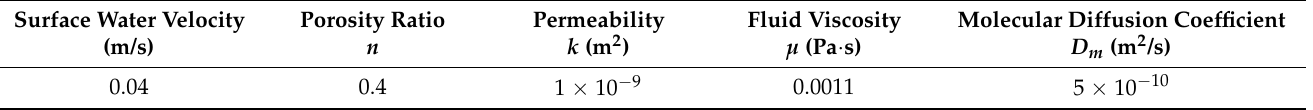
Table 1. Parameter settings of the numerical simulation